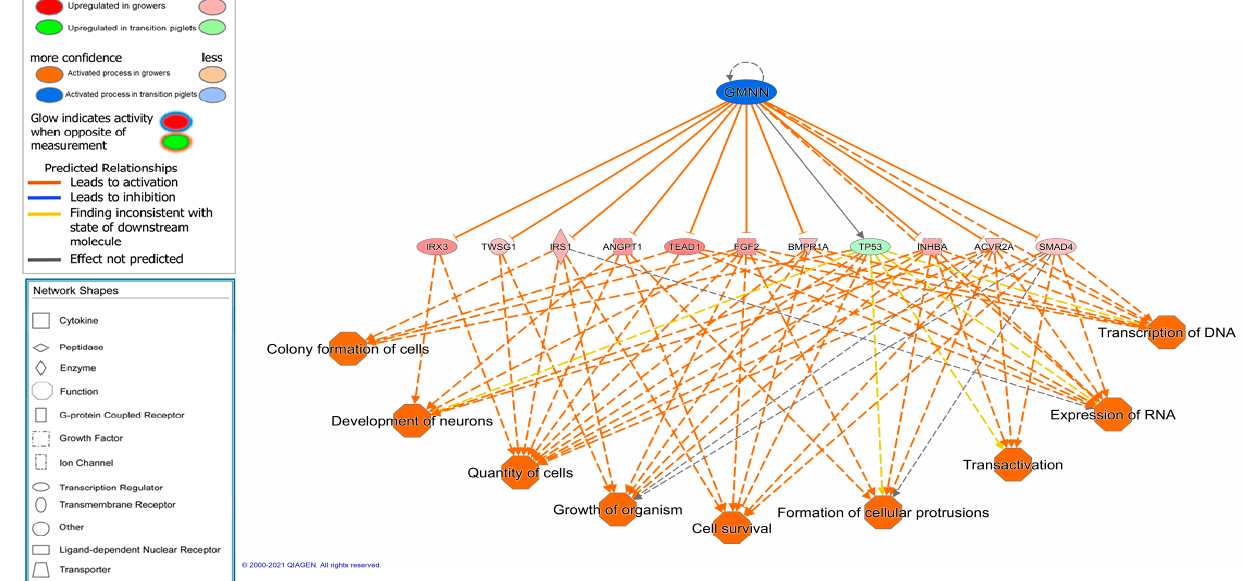
Figure 4. Causal network of MEF2D regulator, which is activated in growers and leads to predicted inhibition of several functions related to proliferation in growers (activated in transition piglets) (z-score = 3.317, p -value = 0.002).